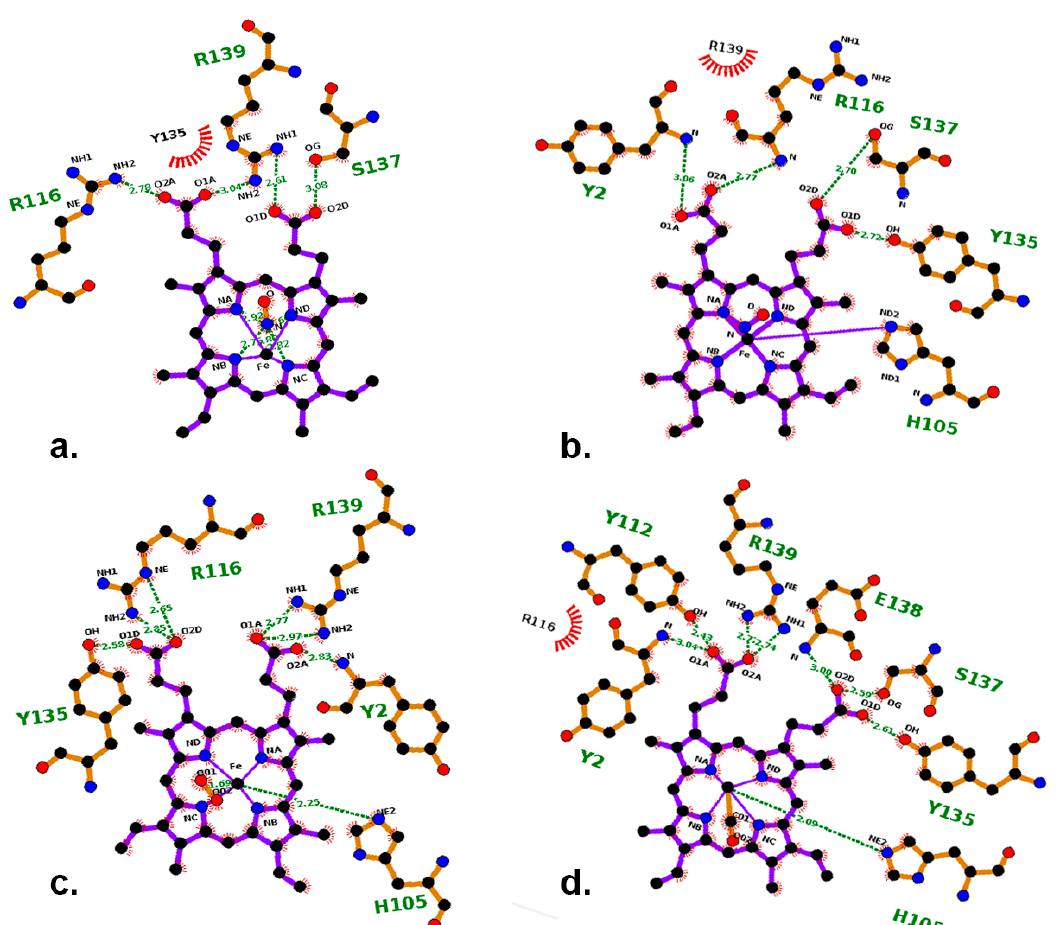
Figure 7. ( a – d ) represents the non-bonded interactions of 5c NO-HNOX, 6c NO-HNOX, O 2 -HNOX and CO-HNOX systems respectively. The propionic moiety of heme (O1A, O2A, O1D, O2D) prominently interacts with functionally important residues such as Y112, Y135, S137, R139, R116 and Y2 throughout the